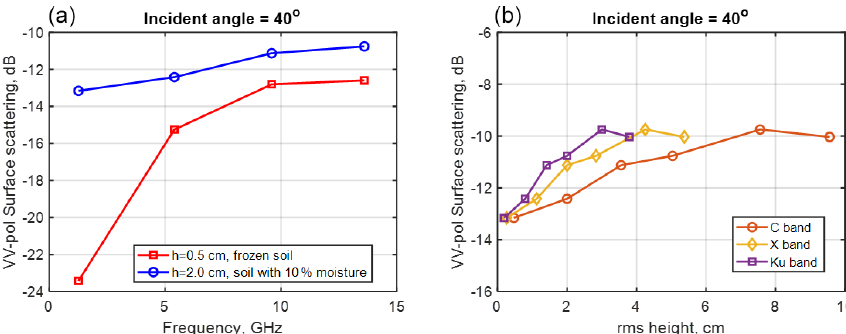
Figure 5. (a) Backscattering at VV polarization as a function of frequency: red curve is results with frozen soil (permittivity 4 + 1 i ) and rms height of 0.5cm, and blue curve is results with soil of 10% moisture and rms height of 2cm. (b) Backscattering at VV polarization as a function of rms height with soil of 10% moisture at C-, X-, and